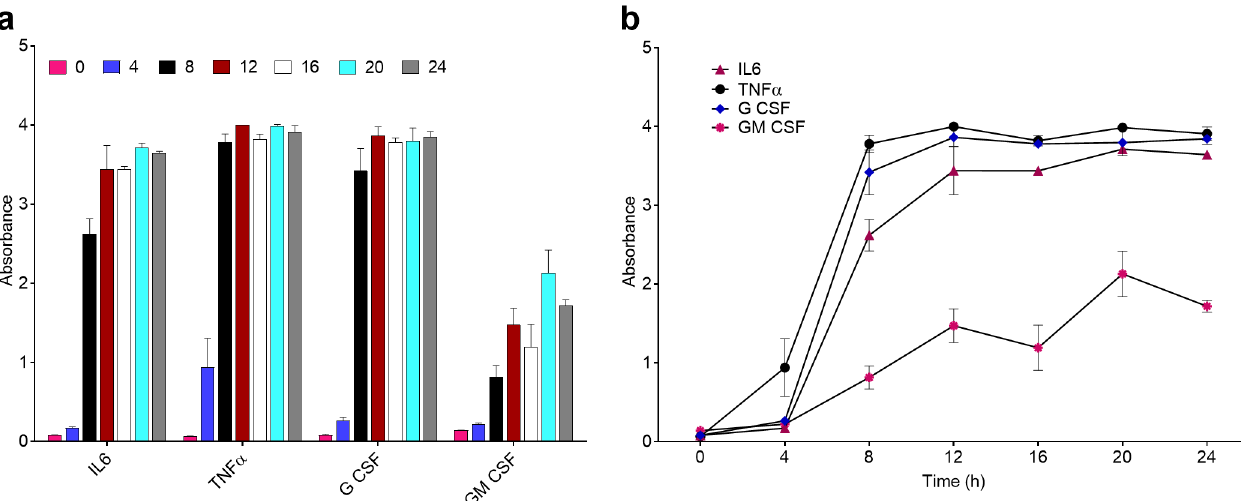
Fig 2. Absorbance measurements from time point study of TLR4+ cells using condition 1. (a) Bar graph representation of cytokines measured over a 24-hour period. The time point 0 h indicates a (–LPS) control to indicate the response of the cells after 24 h with no antigen exposure. (b) Selected TLR4 relevant cytokines plotted over time to demonstrate temporal response. Values are plotted as the mean absorbance (n = 3) with error bars indicating standard deviation of the mean.